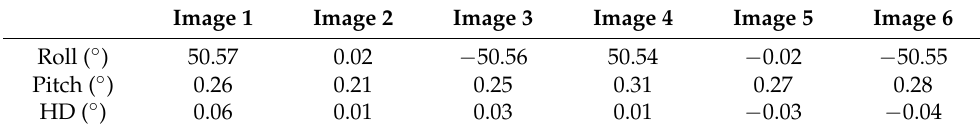
Figure 16. Series of mosaic images of two adjacent sweeping cycles.